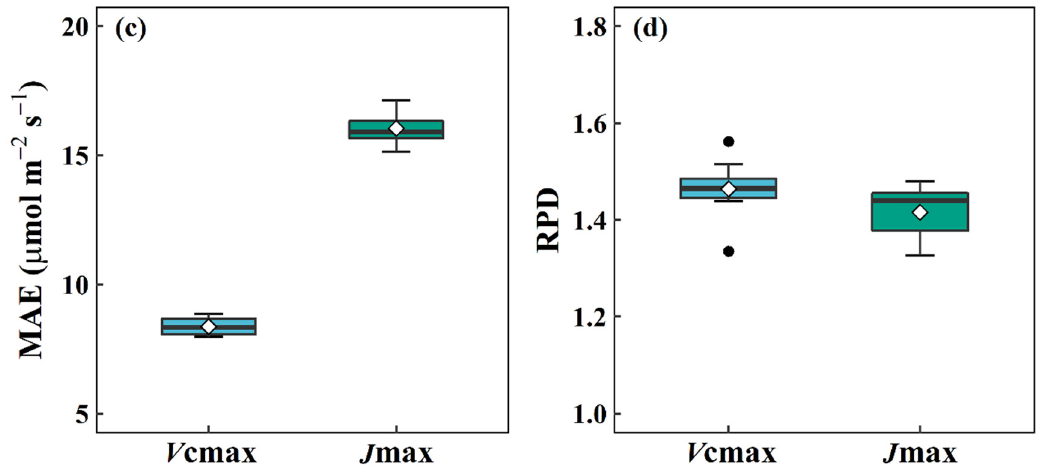
Figure 3. The statistical distributions of the R 2 ( a ), RMSE ( b ), MAE ( c ), and RPD ( d ) values of the ensemble DNN model using a bootstrap bagging approach for predicting the maximum carboxylation rate ( V cmax) and maximum electron transport rate ( J max) in the Naeba dataset. R 2 : coefficient of determination; RMSE: root mean square error; MAE: mean absolute error; RPD: ratio of performance to standard deviation.